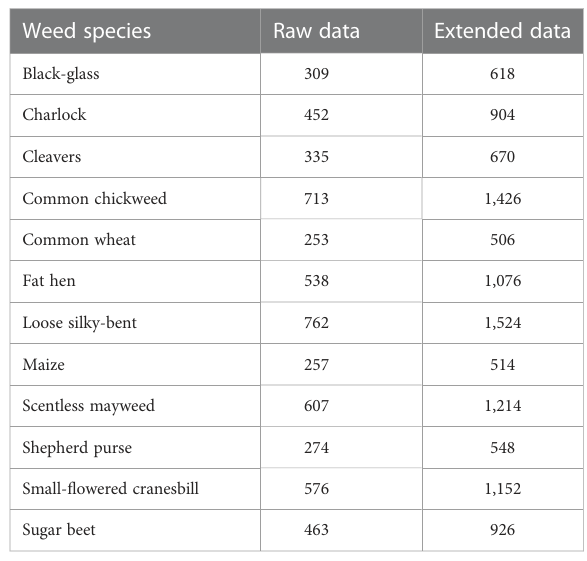
TABLE 4 Data ampli fi cation.